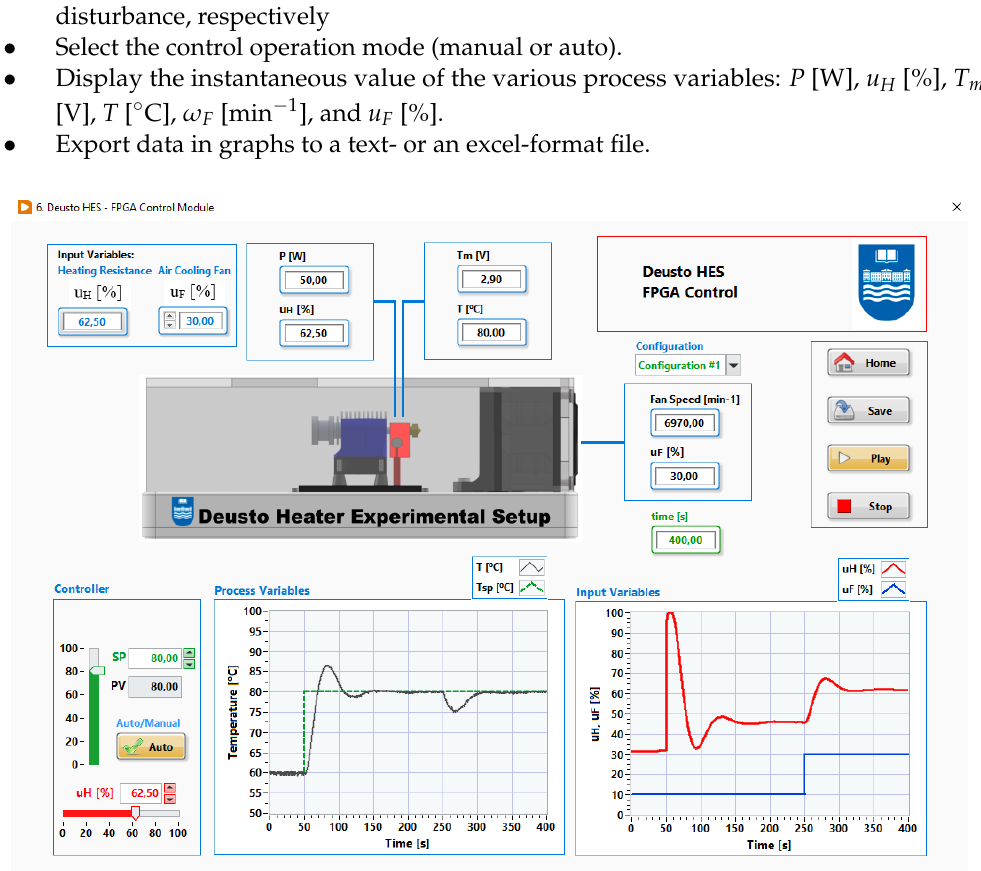
Figure 25. LabVIEW-based application for FPGA control.